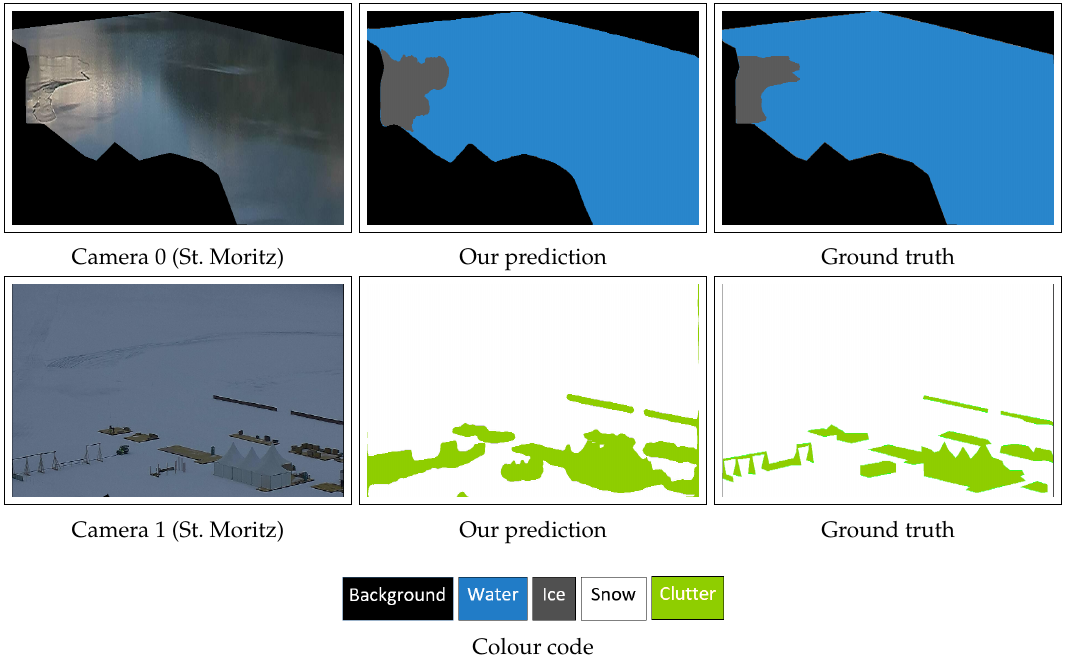
Figure 18. Qualitative lake ice segmentation results on webcam images. The colour code is also shown.